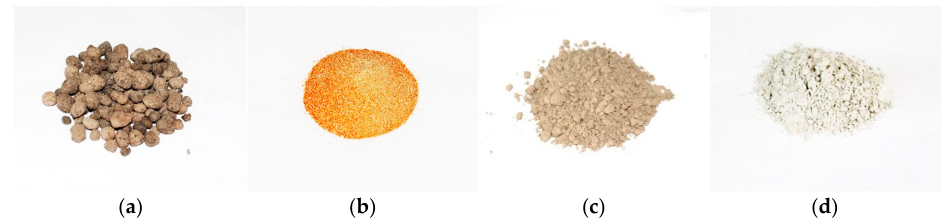
Figure 1. Photographs of ( a ) LECA, ( b ) DS, ( c ) FA, and ( d ) GGBS.